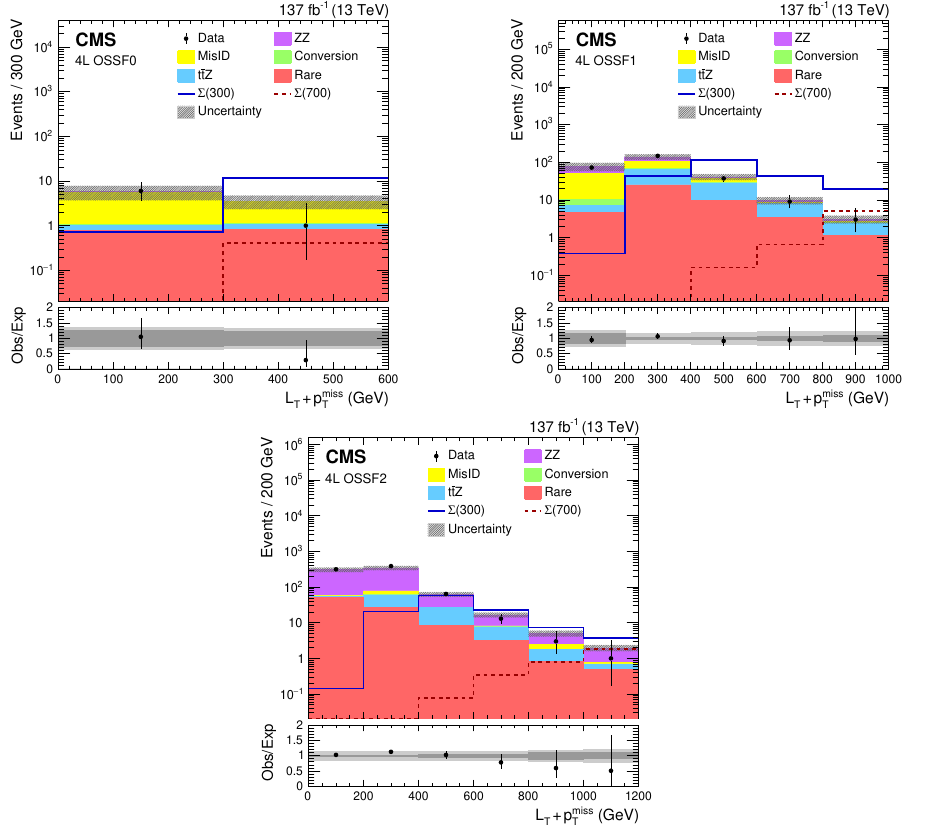
Figure 4 . Type-III seesaw signal regions in 4L OSSF0 (upper left), OSSF1 (upper right), and OSSF2 (lower) events. The total SM background is shown as a stacked histogram of all contributing processes. The predictions for type-III seesaw models with (cid:6) masses of 300 and 700 GeV in the (cid:13)avor-democratic scenario are also shown. The lower panels show the ratio of observed to expected events. The hatched gray bands in the upper panels and the light gray bands in the lower panels represent the total (systematic and statistical) uncertainty of the backgrounds in each bin, whereas the dark gray bands in the lower panels represent only the statistical uncertainty of the backgrounds. The rightmost bins contain the over(cid:13)ow events in each